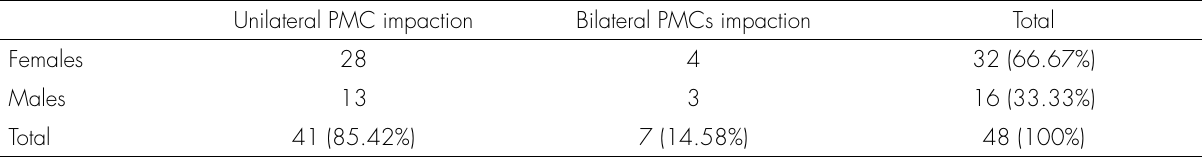
Table I. Distribution of subjects with impaction of permanent mandibular canine/s.